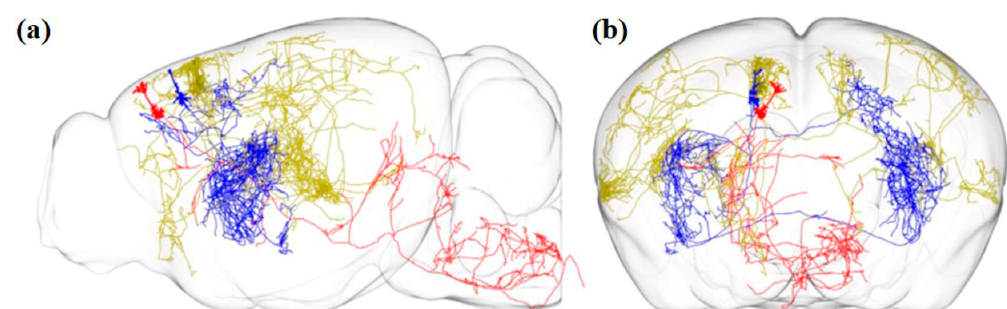
Figure 4. Axonal arbor for three cortical projection neurons of layer five of the motor cortex collapsed in the sagittal plane ( a ) and coronal plane ( b ). Intratelencephalic neurons shown in yellow and green color are projected to other cortical areas and the striatum with a higher level of projection heterogeneity. Pyramidal tract neurons (red) are connecting the motor cortex with hindbrain and midbrain. Reconstructions are retrieved from MouseLight Neuron Browser [76]. Total axonal lengths of shown neurons are 44.7, 30.1 and 13.4 cm for yellow (ID: AA0100), blue (ID: AA0267), and red (ID: AA0180), respectively. Reprinted with the permission of [75]. Cells 2020 , 9 , x